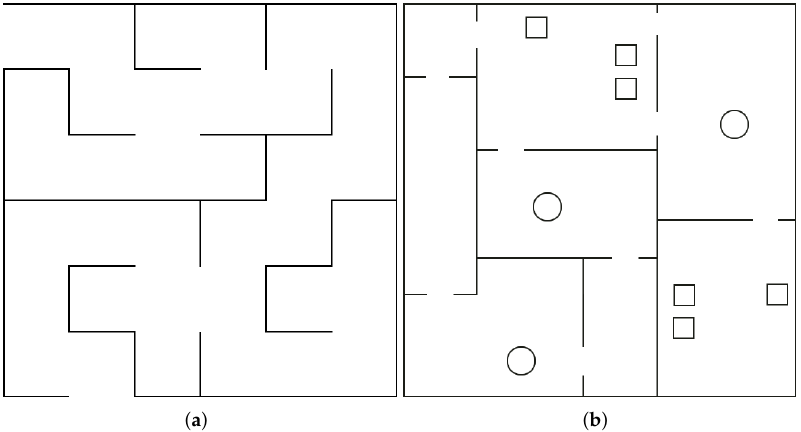
Figure 6. Two types of synthetic maps. ( a ) Maze from robotcraft competition (https://robotcraft. ingeniarius.pt/, https://github.com/ingeniarius-ltd/robotcraft_maze, accessed on 16 August 2022). ( b ) Synthetically generetaed rooms.